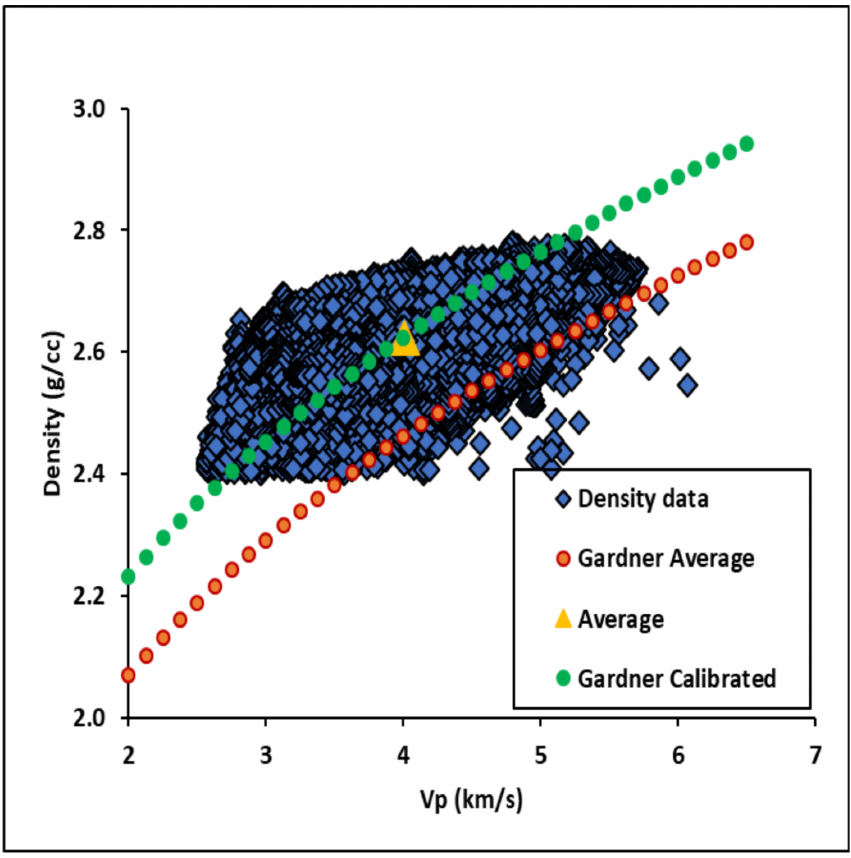
Figure 8. Gardner’s [37] velocity ‐ density transform plot of studied wells in the Goldwyer formation. The empirical trend does not fall on mean value (yellow triangle), and so, the curve is shifted to match (green trend line).